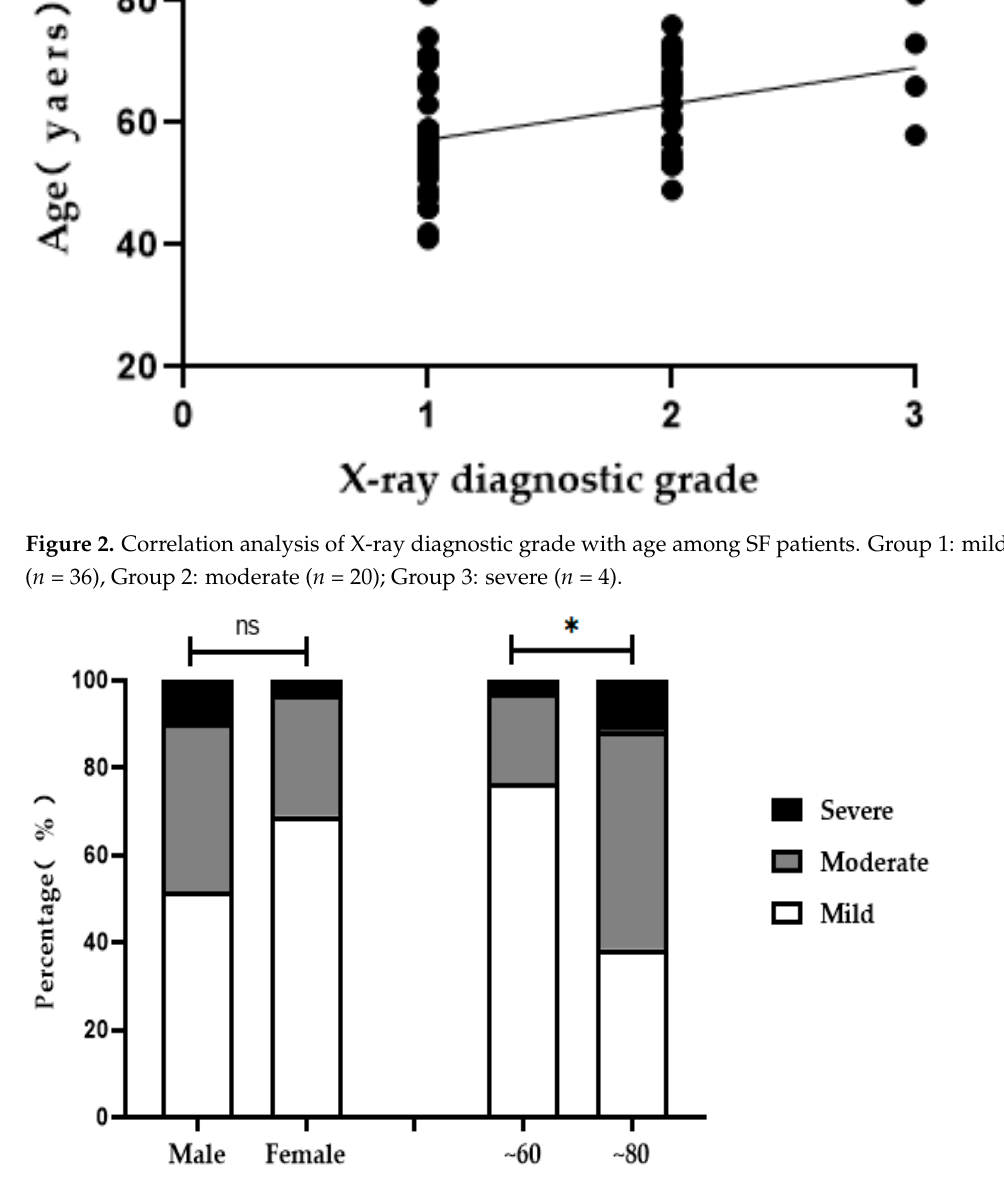
Table 3. Serum SDF-1, CXCR4, MCP-1, ERK1/2 and NF- κ B levels in the SF group and control group [M ( P 25 , P 75 )].